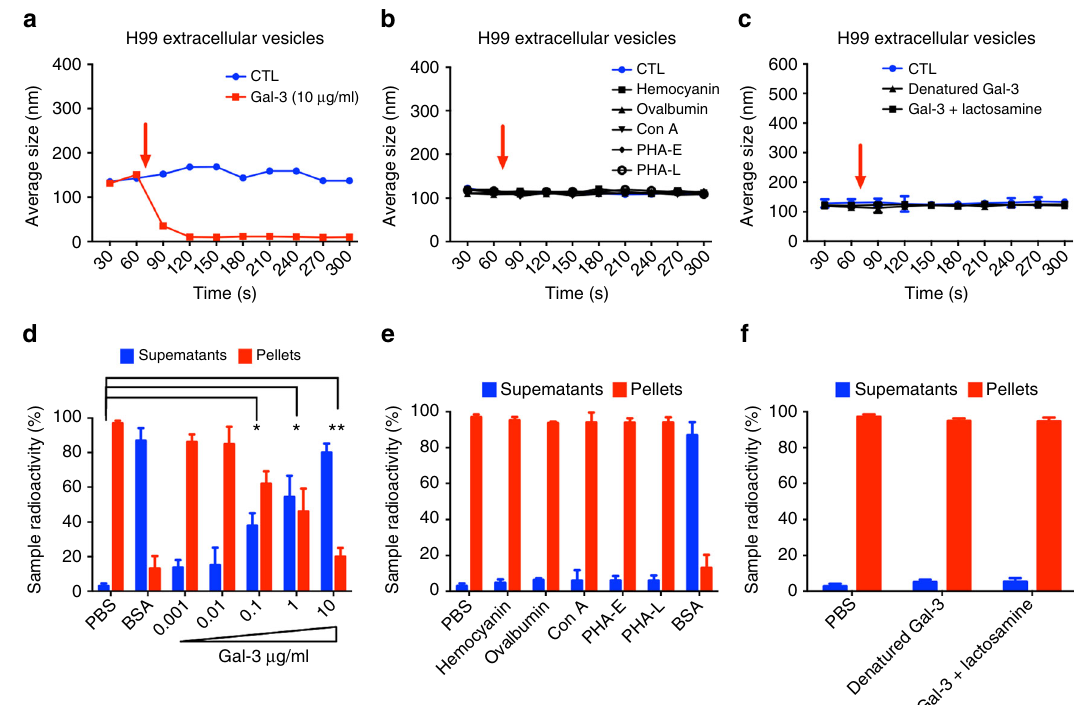
Fig. 7 Gal-3 disrupts C . neoformans extracellular vesicles. Temporal kinetics of vesicle disruption mediated by Gal-3 were measured by dynamic light scattering over ten 30 s to read the population average size ( a − c ). The addition of Gal-3 10 μ g initially leads to disruption ( a ). The same samples were read fi rst without (blue line) and then with the presence of Gal-3 (red line), which was added between the 60 and 90 s intervals (red arrow). Hemocyanin, ovalbumin, concanavalin A (Con A), phytohaemagglutinin E (PHA-E), and phytohaemagglutinin L (PHA-L) were used as control ( b ). Also denatured Gal-3 and Gal-3 pre-incubated with lactosamine were used as control ( c ). Puri fi ed radiolabeled vesicles after 72 h post [1- 14 C] palmitic acid addition were resuspended in PBS, BSA, Gal-3 (0.001 to 10 μ g/ml) ( d ), hemocyanin, ovalbumin, Con A, PHA-E, and PHA-L ( e ), denatured Gal-3 and Gal-3 pre-incubated with lactosamine ( f ), and supernatant (blue bars) and pellet (red bars) radioactivity were assessed and normalized to 100% radioactivity for each individual sample. Bars represent the mean ± SD from triplicate samples. Statistically signi fi cant differences are denoted by asterisks (* p < 0.05, ** p < 0.005, unpaired Student ’ s t -test)